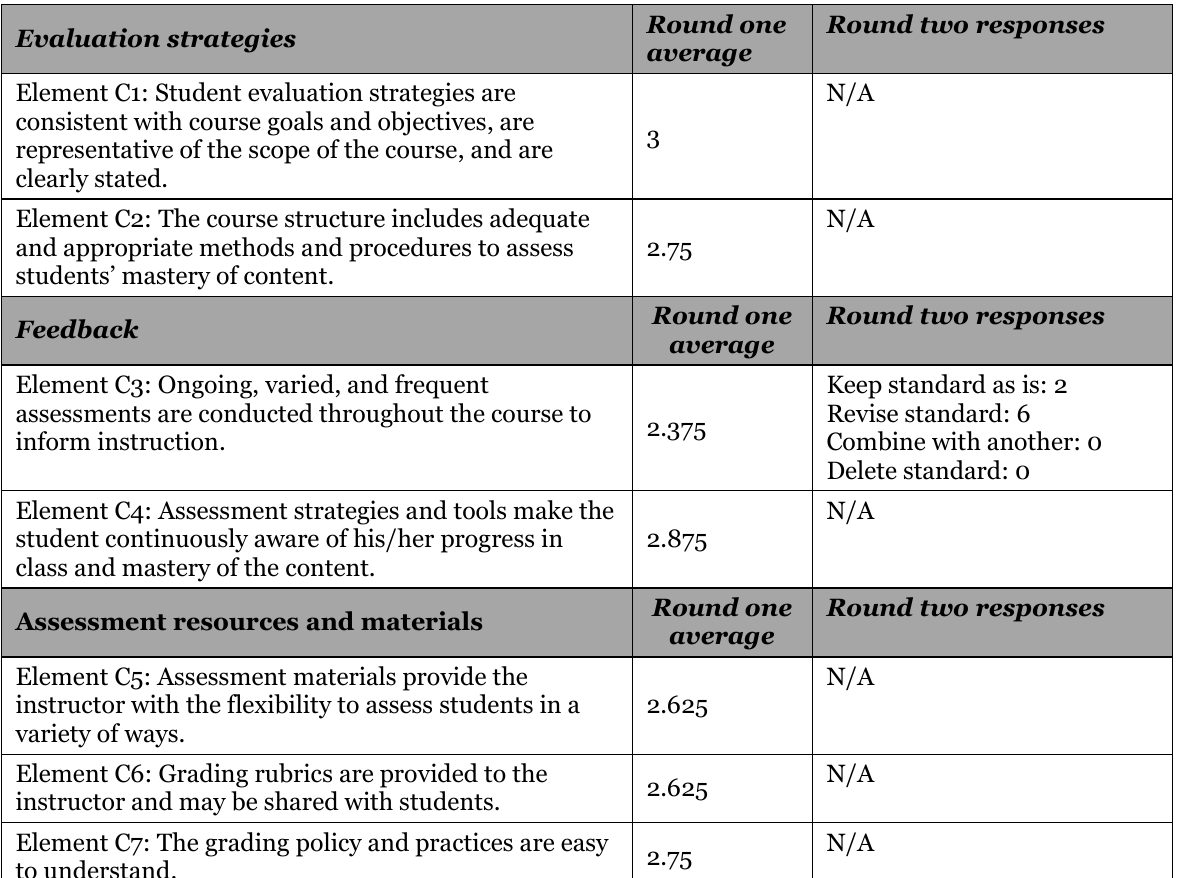
Table 4 Section C: Student Assessment Elements Evaluation strategies